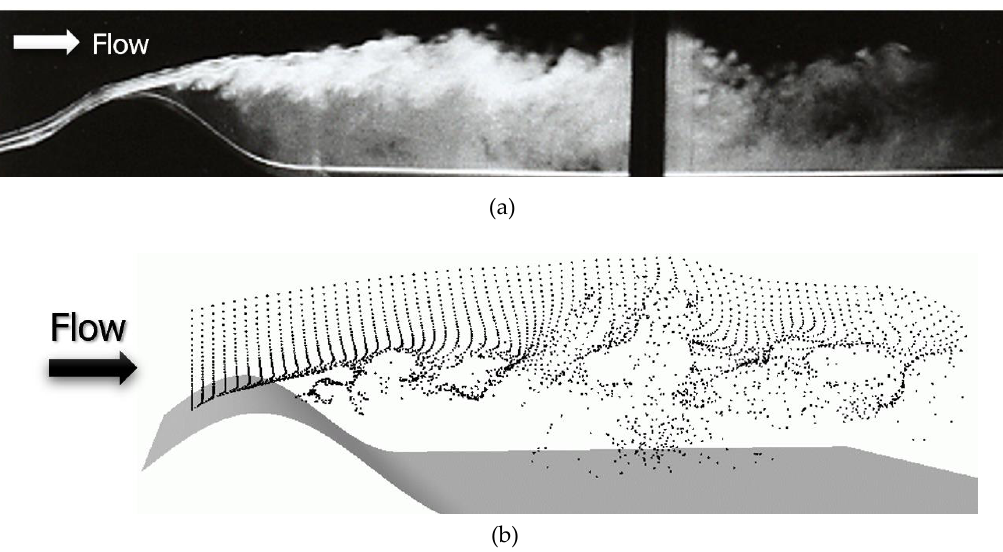
Figure 5. Comparison of the instantaneous flow pattern around a two-dimensional ridge model (side view, y = 0). (a) The wind tunnel experiment shows the smoke-wire technique at a wind speed of 1.5 m/s. (b) Visualization of the numerical simulation and passive particle tracking method.